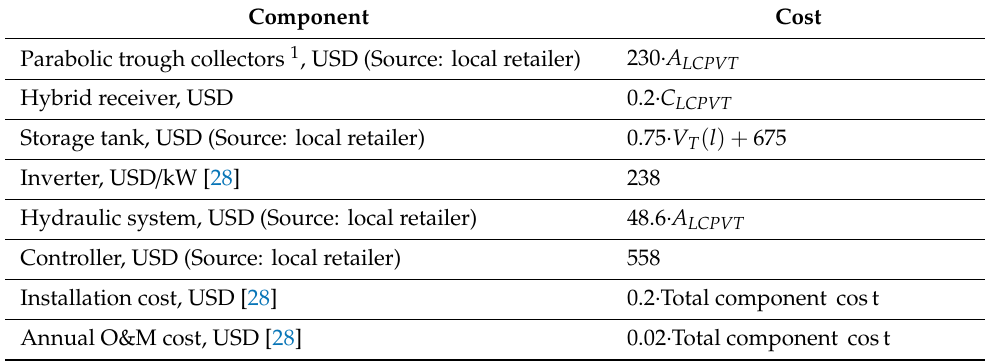
Table 2. Cost breakdown of the LCPV / T